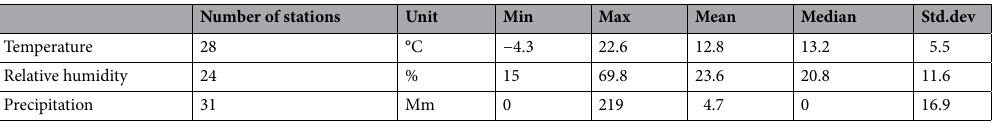
Table 1. Statistical indicators of temperature, relative humidity and precipitation in January, February and March for Salar de Atacama study area.